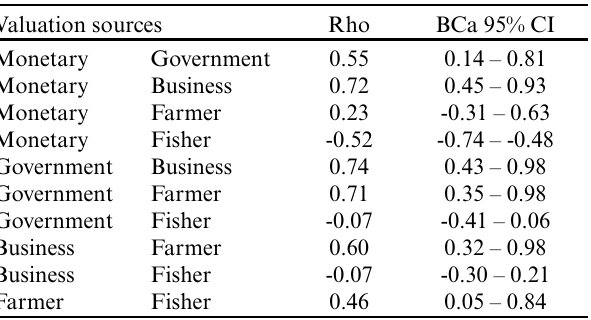
Table 2 . Spearman’s rho correlations and BCa 95% confidence intervals between valuation scores of freshwater ecosystem services by monetary assessment and different stakeholder groups in Shaoguan, China.